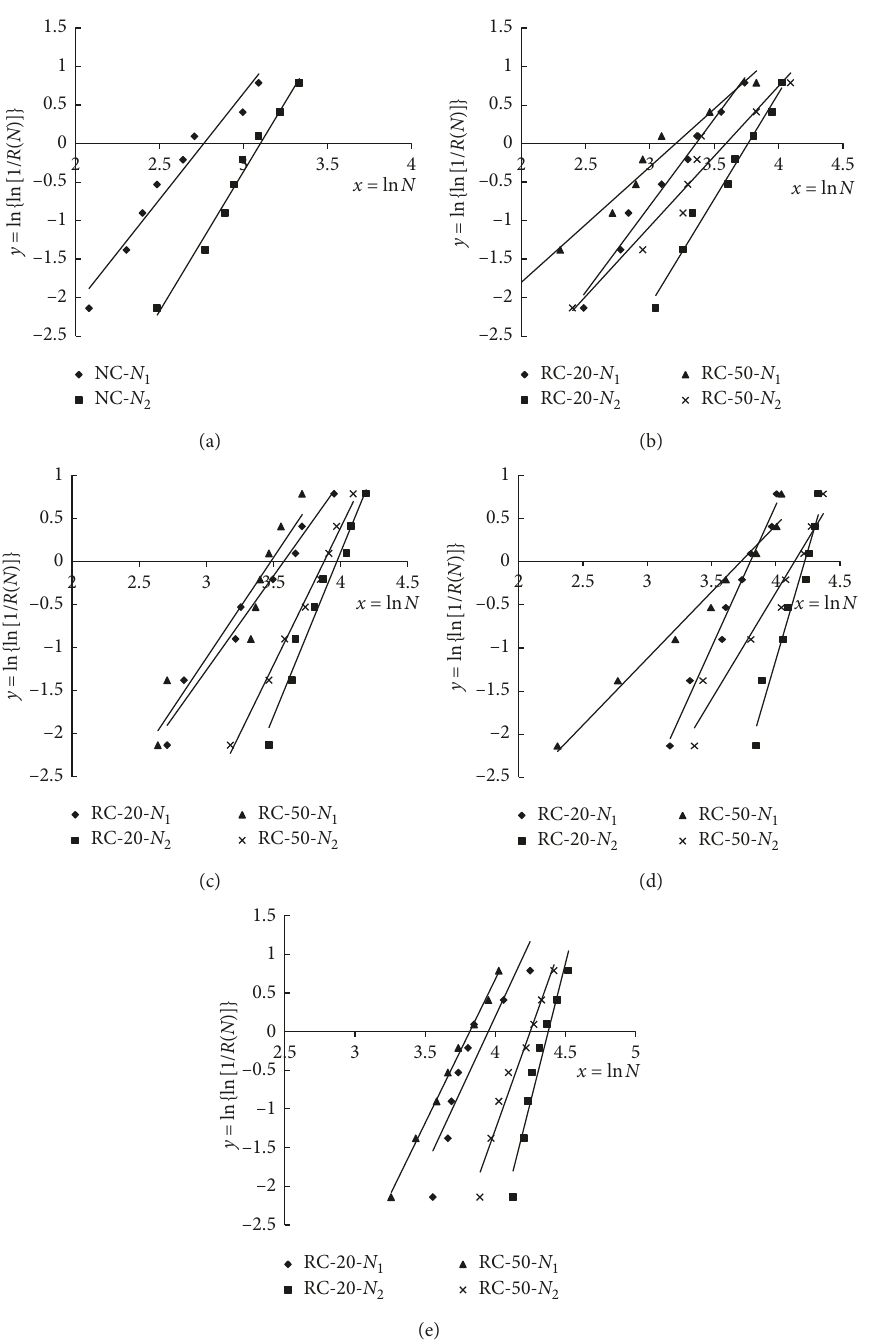
Figure 5: Weibull distributions of N for the rubber concrete specimens at 25 ° C. Rubber powder: (a) 0%, (b) 5%, (c) 10%, (d) 15%, and (e)